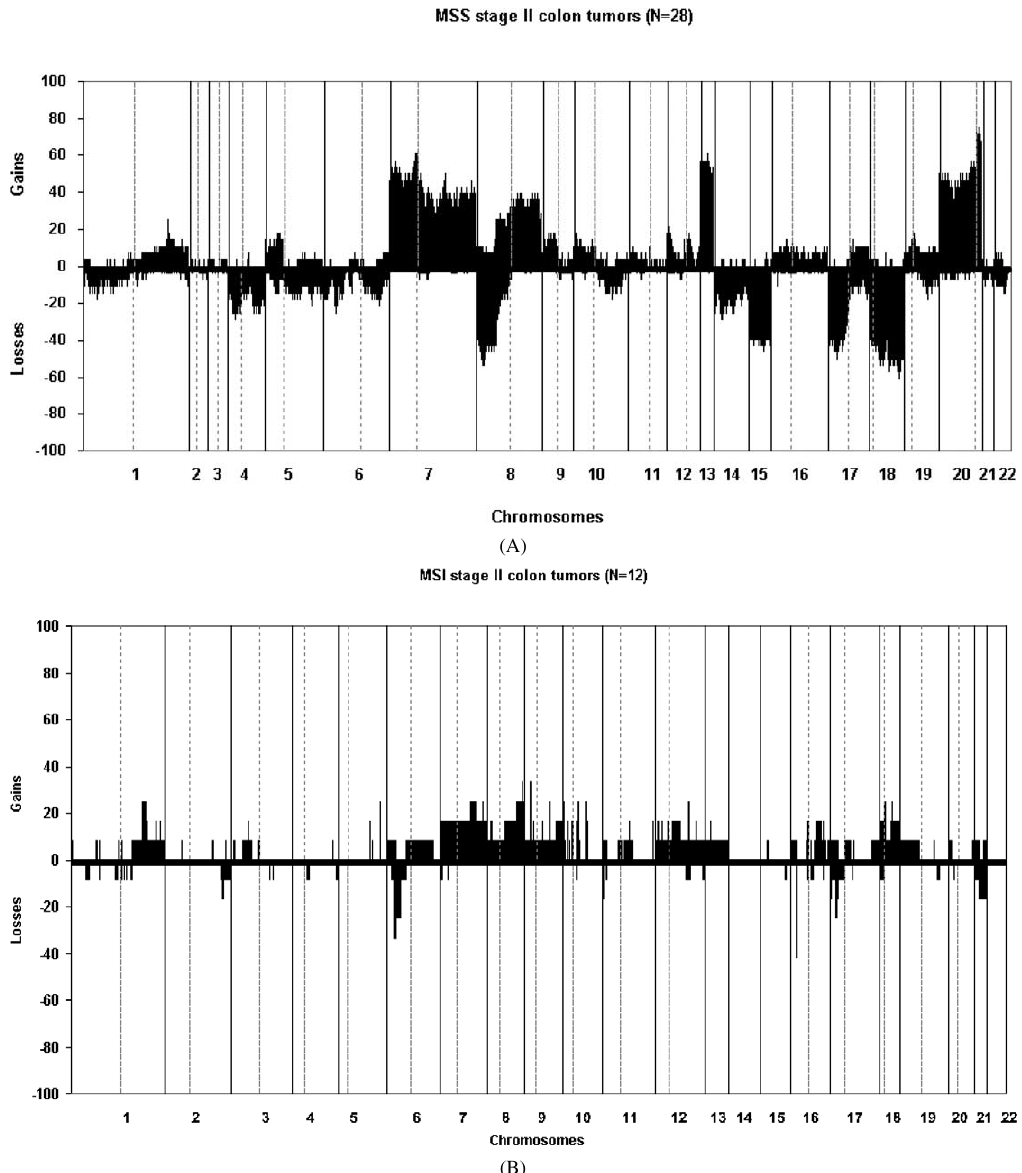
Fig. 2. Percentage of chromosomal gains and losses measured by array CGH in (A) 28 MSS and (B) 12 MSI stage II colon cancers patients. X -axis displays 44,000 oligo-nucleotides in genomic order (chromosomes 1–22). Y -axis displays percentage of tumor with gains ( > 0) or losses ( < 0). Boundaries of chromosomes are indicated by black vertical lines and locations of centromeres are indicated by dotted